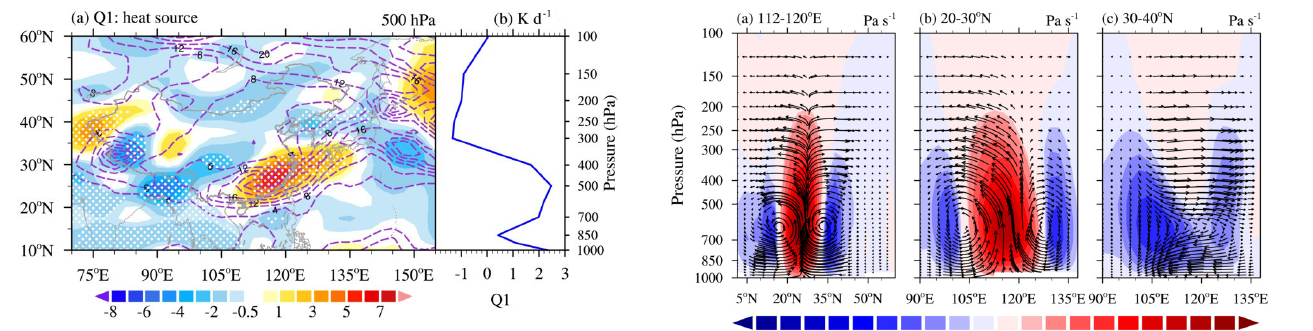
Figure 10. As Fig. 6 except for the results from the LBM. For clar- ity, ω is multiplied by −